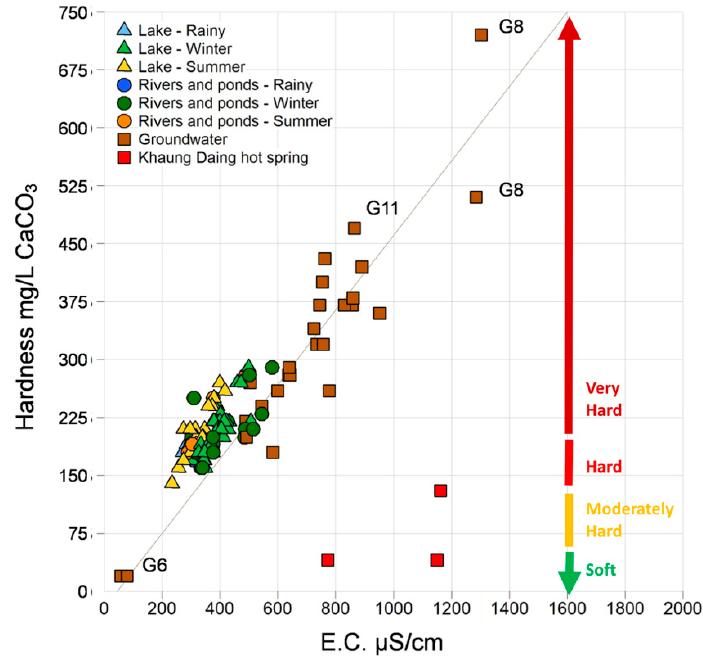
Figure 7. Hardness (CaCO 3 in mg/L) versus electrical conductivity; Water containing CaCO 3 at con- centrations below 60 mg/L is generally considered as soft; 60–120 mg/L, moderately hard; 120–180 mg/L, hard; and more than 180 mg/L, very hard